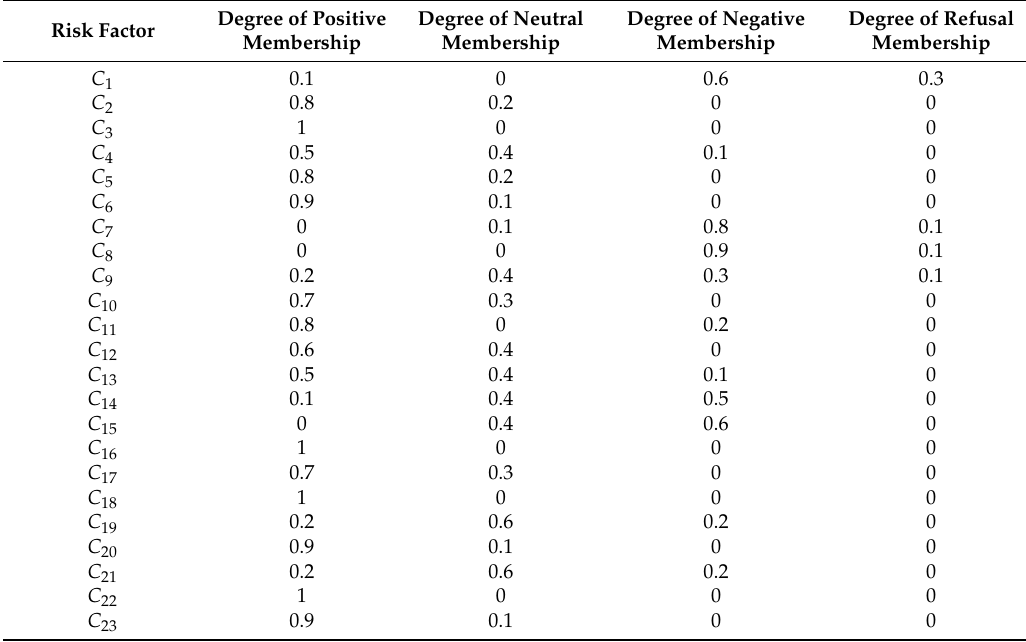
Table 8. The picture fuzzy risk factor importance matrix.